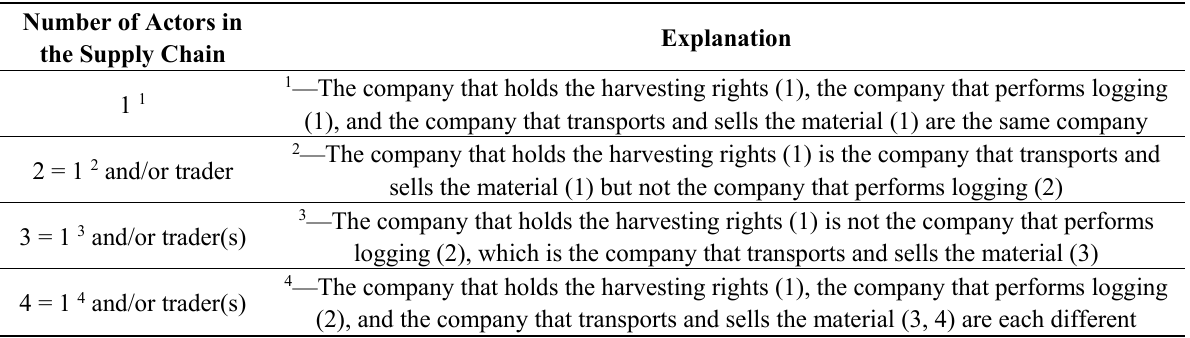
Table 3. Map and recoding of the initial information of the supply